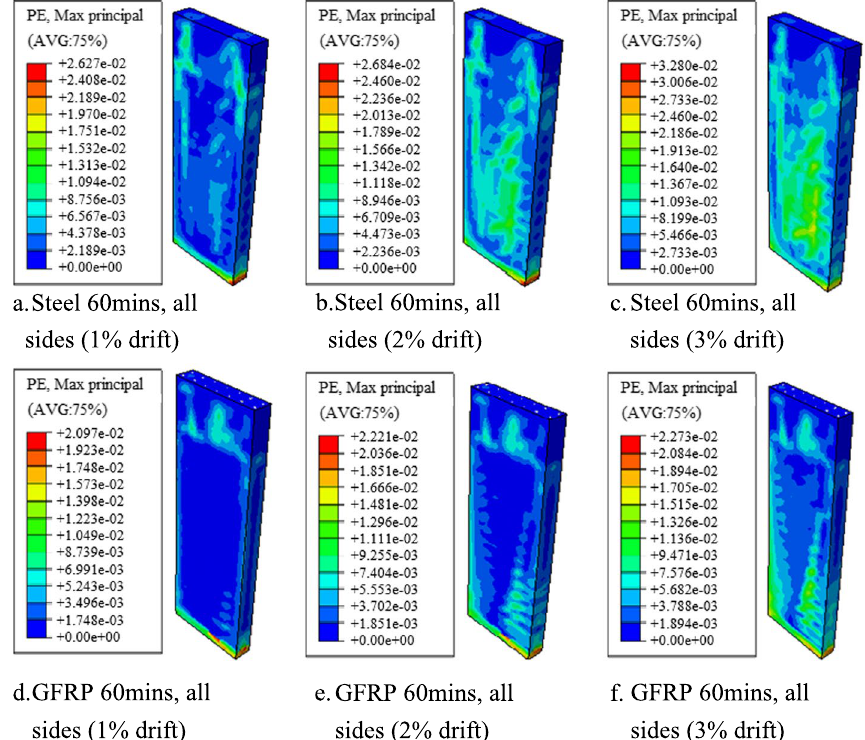
Fig. 49 distribution of crack for steel or GFRP reinforced shear wall. a Steel 60 min, all sides (1% drift). b Steel 60 min, all sides (2% drift). c Steel 60 min, all sides (3% drift). d GFRP 60 min, all sides (1% drift). e GFRP 60 min, all sides (2% drift). f GFRP 60 min, all sides (3%